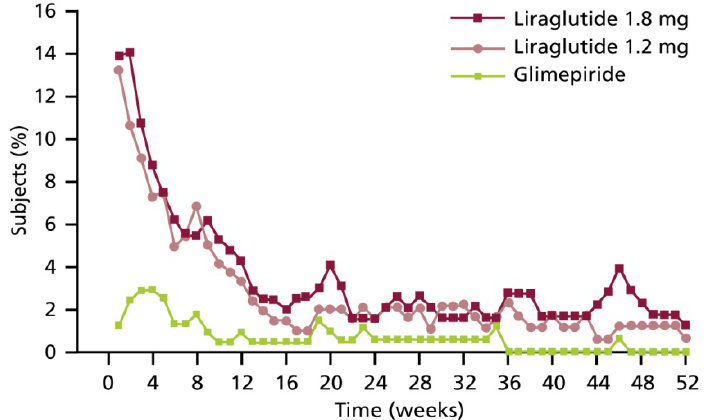
Figure 12. Proportion of Subjects with Nausea by Week and Treatment in LEAD-3